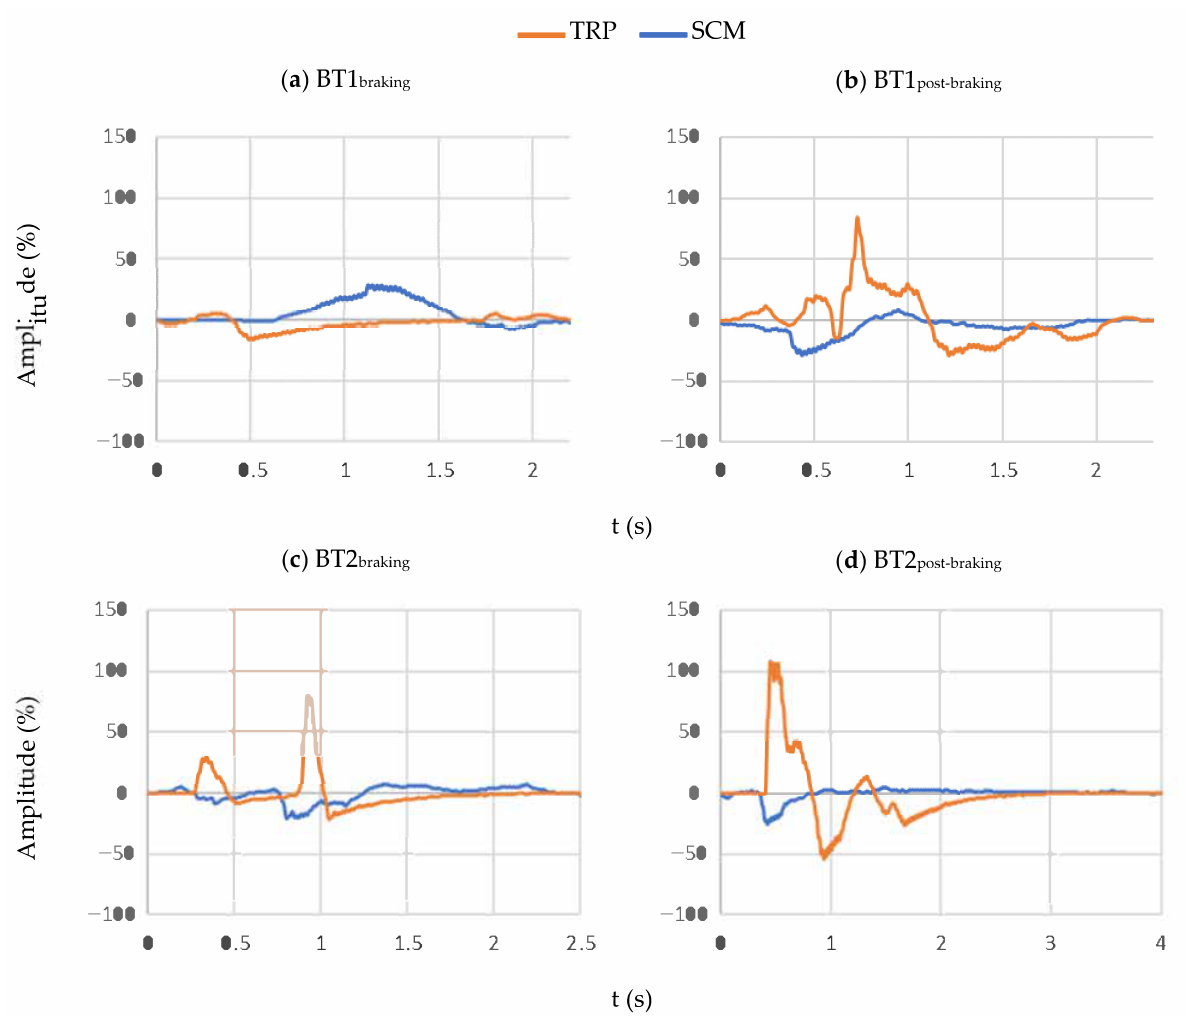
Figure 6. sEMG signal from the SCM and TRP muscles from one volunteer. The signal has been split according to the experiment and to the time of the braking. ( a ) BT1 braking time; ( b ) BT1 post-braking time; ( c ) BT2 braking time; ( d ) BT2 post-braking